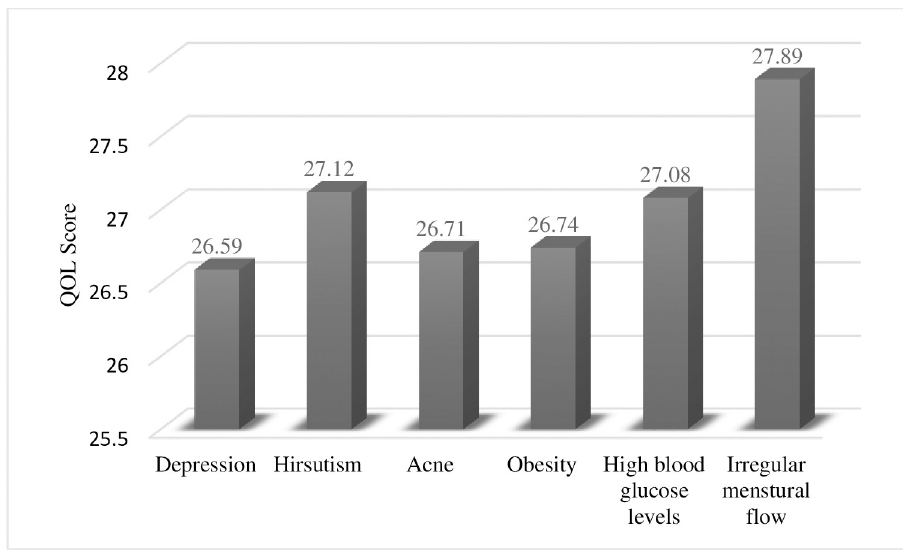
Fig 2. Bar graph showing the mean QOL scores according to clinical conditions in patients with PCOS. QOL, quality of life; PCOS, polycystic ovary syndrome.